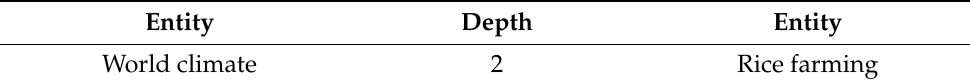
Table 5. Search form for the relation among entities.